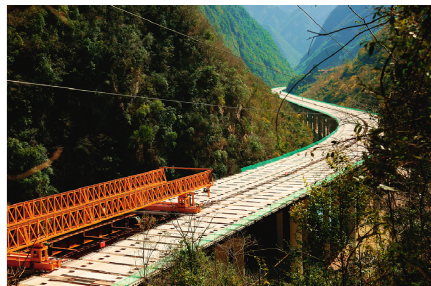
Figure 1: The prototype bridge (TGCB).